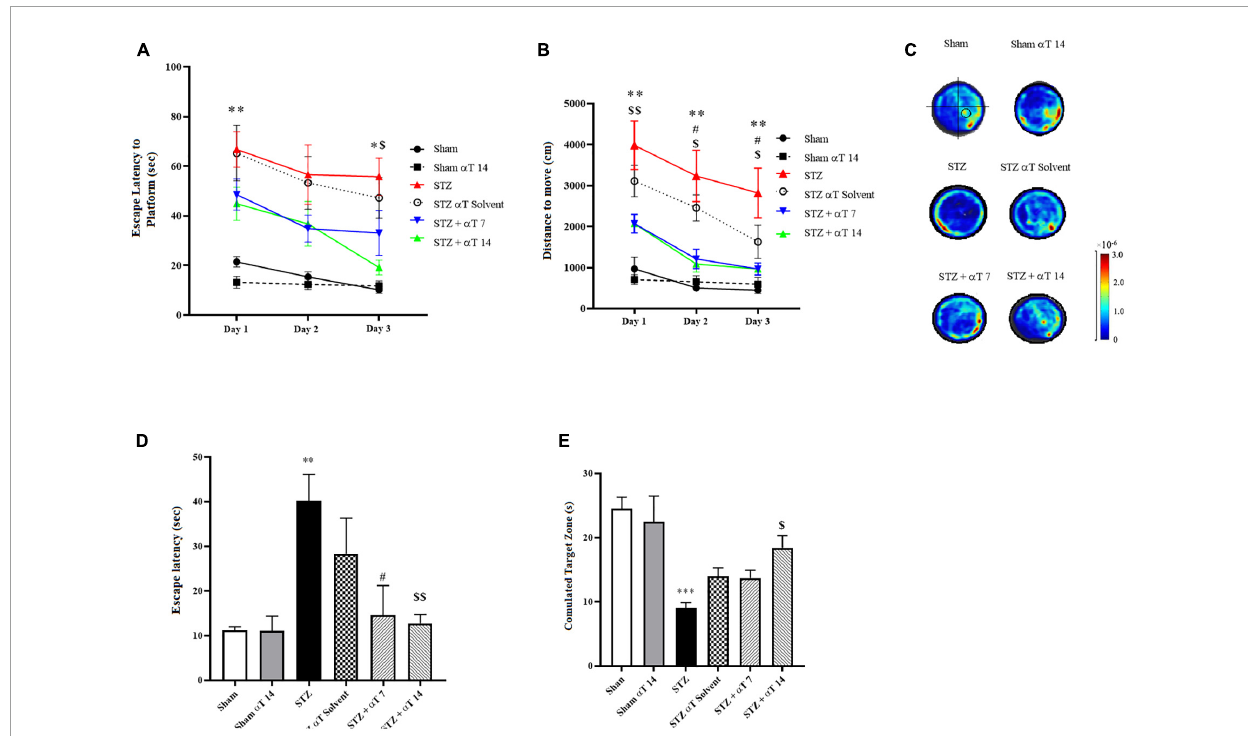
FIGURE2 Effect of α -Tocopherol on learning and memory in icv-STZ induced rats by using Morris water maze (MWM) test. A Two-way ANOVA of (A) escape latency (the time to find the hidden platform) ( ∗ P < 0.05, ∗∗ P < 0.01 icv-STZ compared to the sham group; $ P < 0.05 icv-STZ compared to the STZ + α -Tocopherol 14) and (B) distance traveled indicated that the performance of icv-STZ induced rats was inferior to that of sham and α -Tocopherol rats during place training ( ∗∗ P < 0.01 icv-STZ compared to the sham group; # P < 0.05 icv-STZ compared to the STZ + α -Tocopherol 7 and $ P < 0.05, $$ P < 0.01 icv-STZ compared to the STZ + α -Tocopherol 14). (C) Heat maps of the swim patterns during probe testing, as examples. A black circle in the bottom right quadrant of the heat map indicates where the platform is located. (D) During the probe trial, icv-STZ-induced rats spent more time finding the hidden platform at the former location of the platform than did the sham and groups [icv-STZ compared to sham ( ∗∗ P < 0.01), STZ + α -Tocopherol 7 ( # P < 0.05) and STZ + α -Tocopherol 14 ( $$ P < 0.01) groups]. (E) During the probe trial, icv-STZ rats spent less time in the target quadrant searching for the missing platform than the sham ( ∗∗∗ P < 0.001) and STZ + α -Tocopherol 14 ( # P < 0.05) groups. The pattern of rat movement in MWM. Data are presented as mean ± SEM ( n = 9 rats in each group).